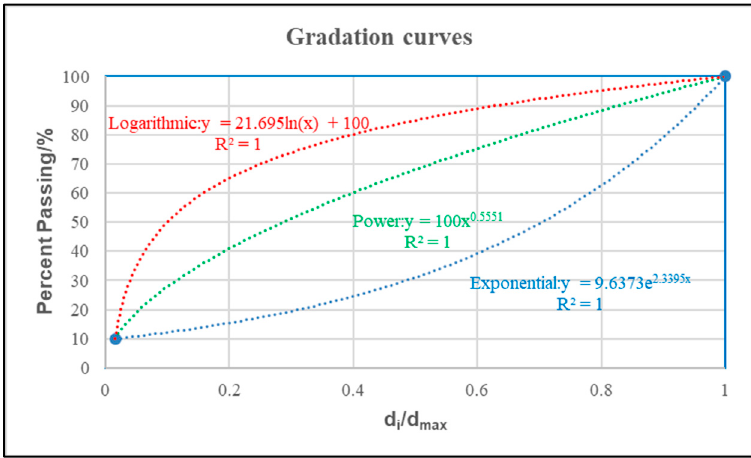
Figure 1. Fitting of gradation curves.